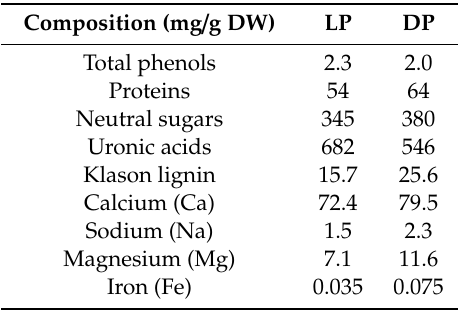
Table 3. Bio-chemical compositions of the cactus